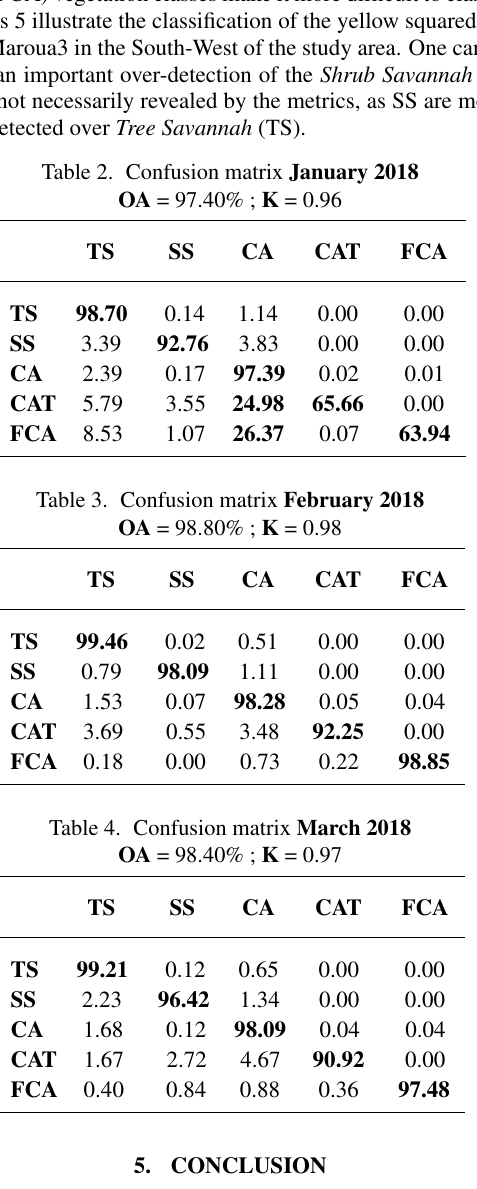
Figure 5. Vegetation and confidence maps. (cid:4) : TS; (cid:4) : SS; (cid:4) : CA; (cid:4) : CAT; (cid:4) : FCA. Top : full area. Middle : zoom of the study yellow squared area (full year). Bottom: Confidence map; (cid:4) : low → (cid:4) : high